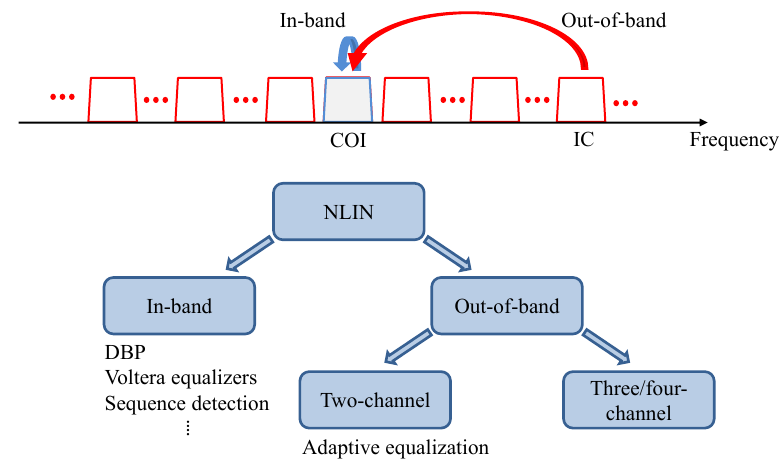
Figure 1. Schematic classification of NLIN types, and methods of mitigating